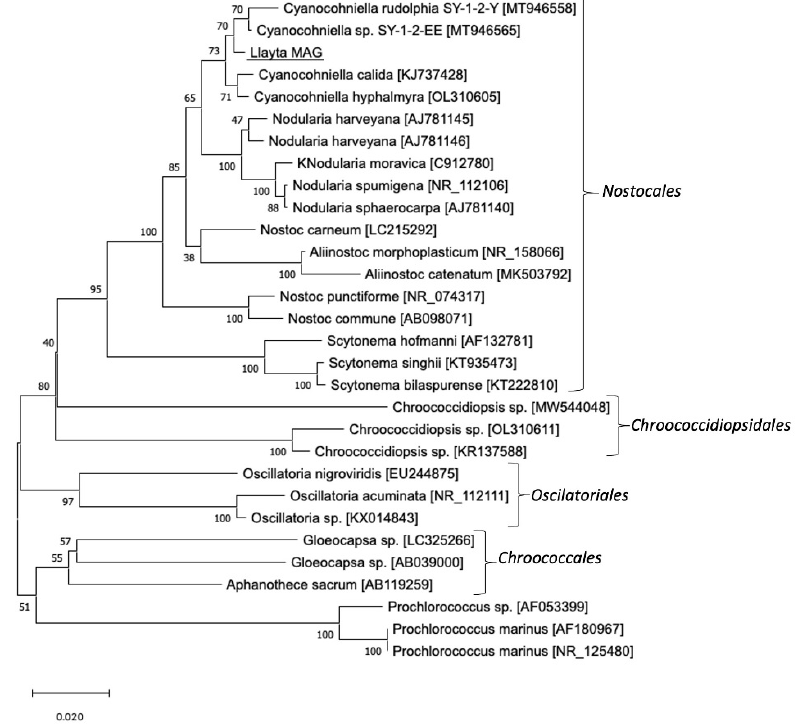
Figure 1. Phylogenetic analysis by Neighbor Joining method based on gene sequences of 16S rRNA . The horizontal bar at the figure’s base represents 0.02 substitutions per nucleotide site. The percentage of trees in which the associated taxa clustered together is shown next to the branches, using a bootstrap of 1000. Evolutionary analysis was conducted in MEGA X.